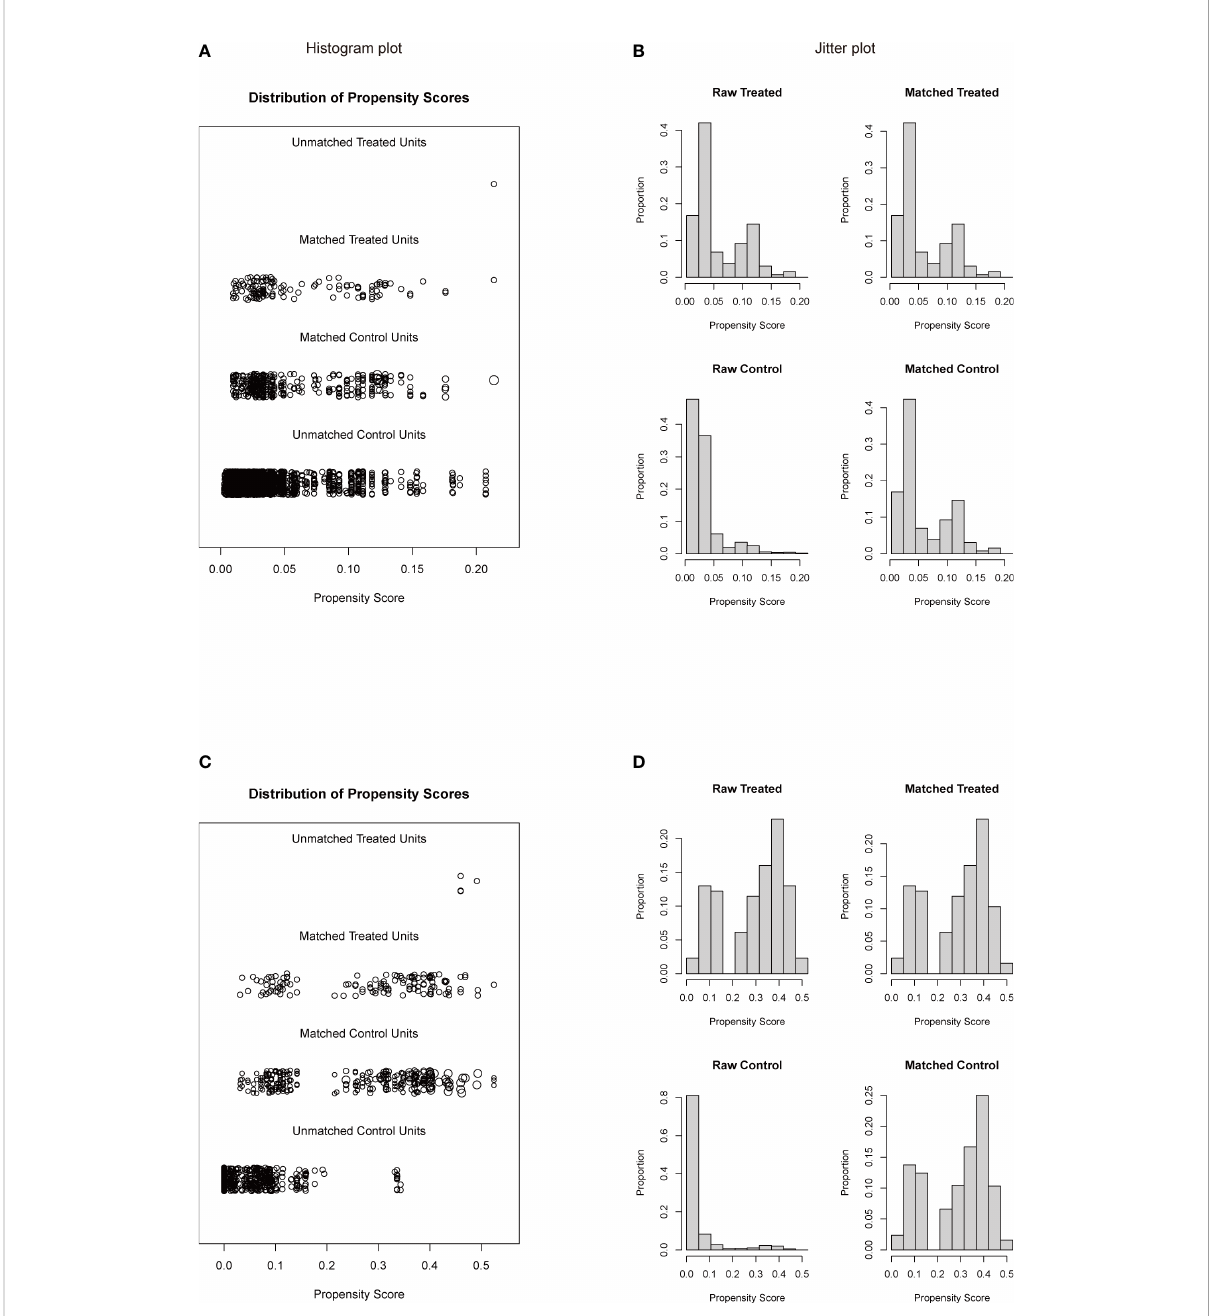
FIGURE 3 Histogram plot (A, C) and jitter plot (B, D) of PSM for rib invasion and the other pT3 or pT4 groups. (A, B), PSM for rib invasion and the other pT3 groups; (C, D), PSM for rib invasion and pT4 groups. PSM: propensity score matching. Other pT3 referred to the pT3 patients without rib